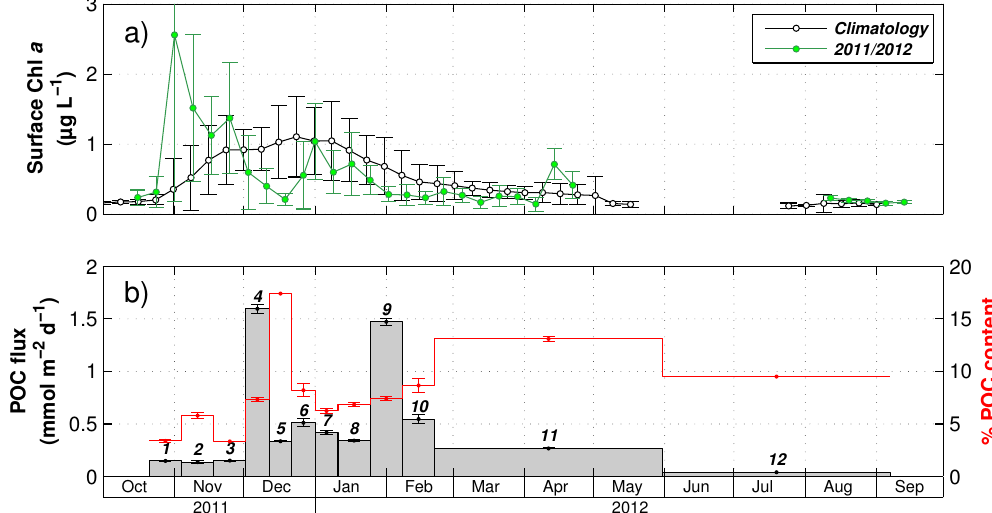
Figure 7. Seasonal variations of surface chlorophyll a and particulate organic carbon (POC) export. (a) Seasonal surface chlorophyll con- centration and 16-year climatology (GlobColour) averaged in a 100km radius around station A3. The black line represents the climatology calculated for the period 1997/2013, whilst the green line corresponds to the sediment trap deployment period (2011/2012). (b) POC flux (grey bars) and mass percentage of POC (red dotted line). Error bars are standard deviations from triplicates, and bold italic numbers refer to cup